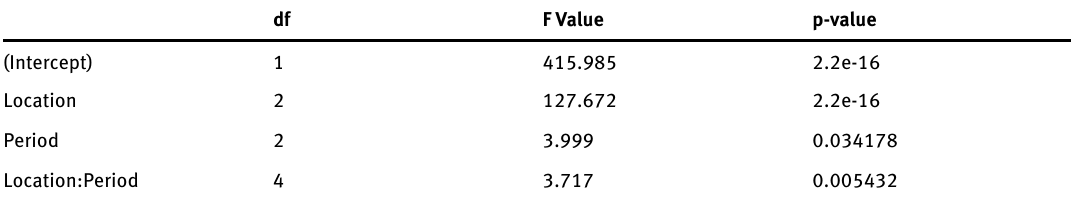
Figure 8. Box plot of distances between newly founded churches and their nearest settlement. Table 3. ANOVA Result for the Response Variable: Distance of Newly Founded Churches to